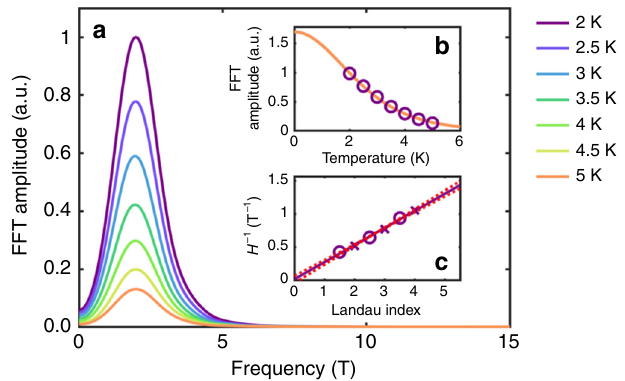
Fig. 3 Analysis of low fi eld oscillations. a The Fourier transform of the oscillations after a polynomial background was subtracted. The inset shows the temperature dependence of the peak amplitude. The orange line in the inset b is the fi t to the Lifshitz – Kosevich equation which was used to determine the effective mass. c Landau level fan diagram shows maxima in ρ xx as crosses and minima as open circles